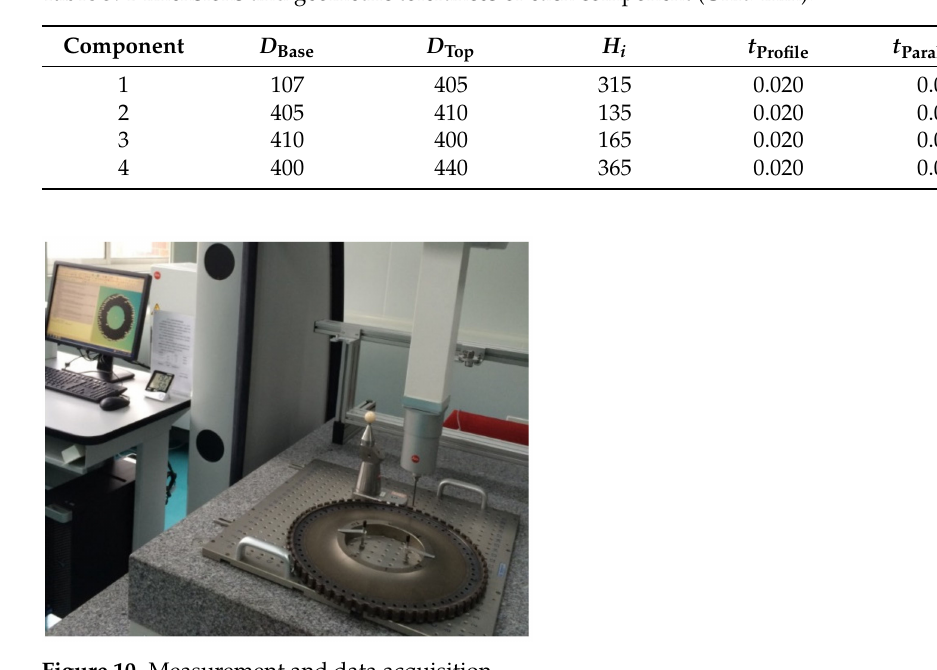
Figure 10. Measurement and data acquisition. Table 4. Jacobian matrixes and variation torsors of points for effective